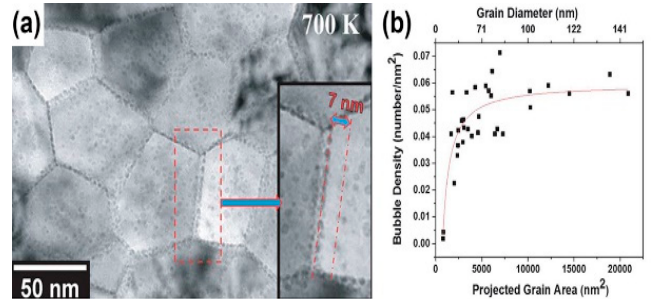
Figure 10. ( a ) Over-focused bright field TEM images of 10 keV He ion irradiation on nanocrystalline iron at calibrated temperatures of 700 K. ( b ) Areal bubble density (number / nm 2 ) vs. grain size (area) for 10 keV He ion irradiation on nanocrystalline iron at 700 K [38].